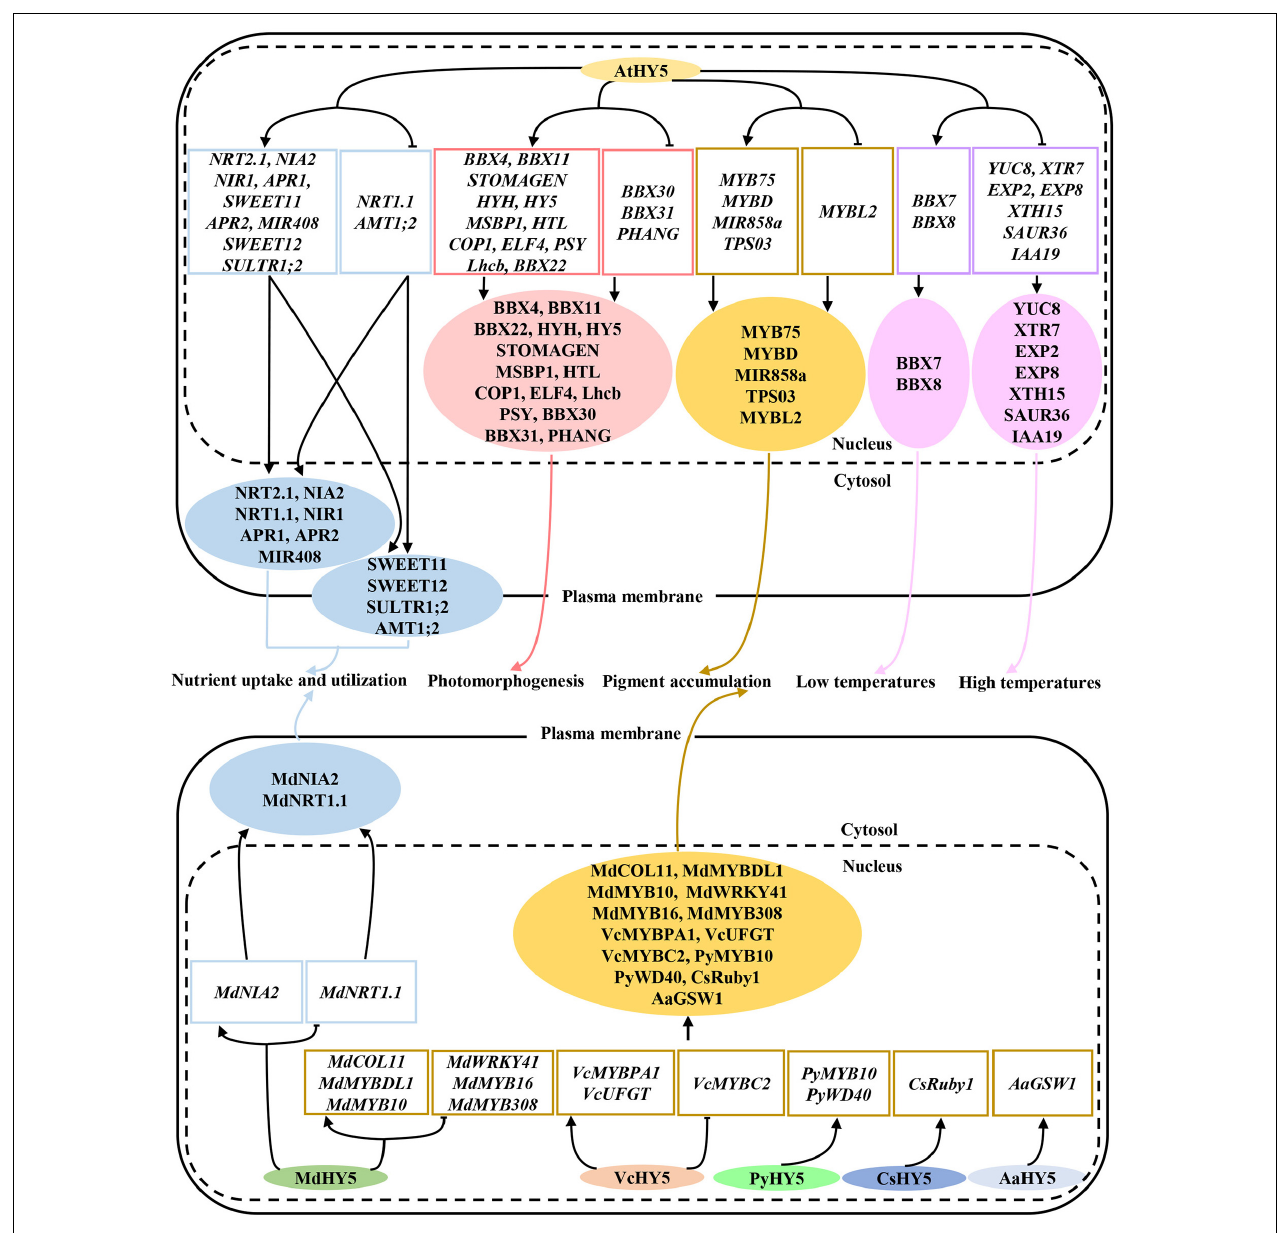
FIGURE 2 | HY5 regulates a variety of physiological and developmental processes in diverse plant species. Various HY5 orthologs are involved in the control of photomorphogenesis, nutrient utilization, pigment accumulation, and low and high temperature signaling by controlling downstream target